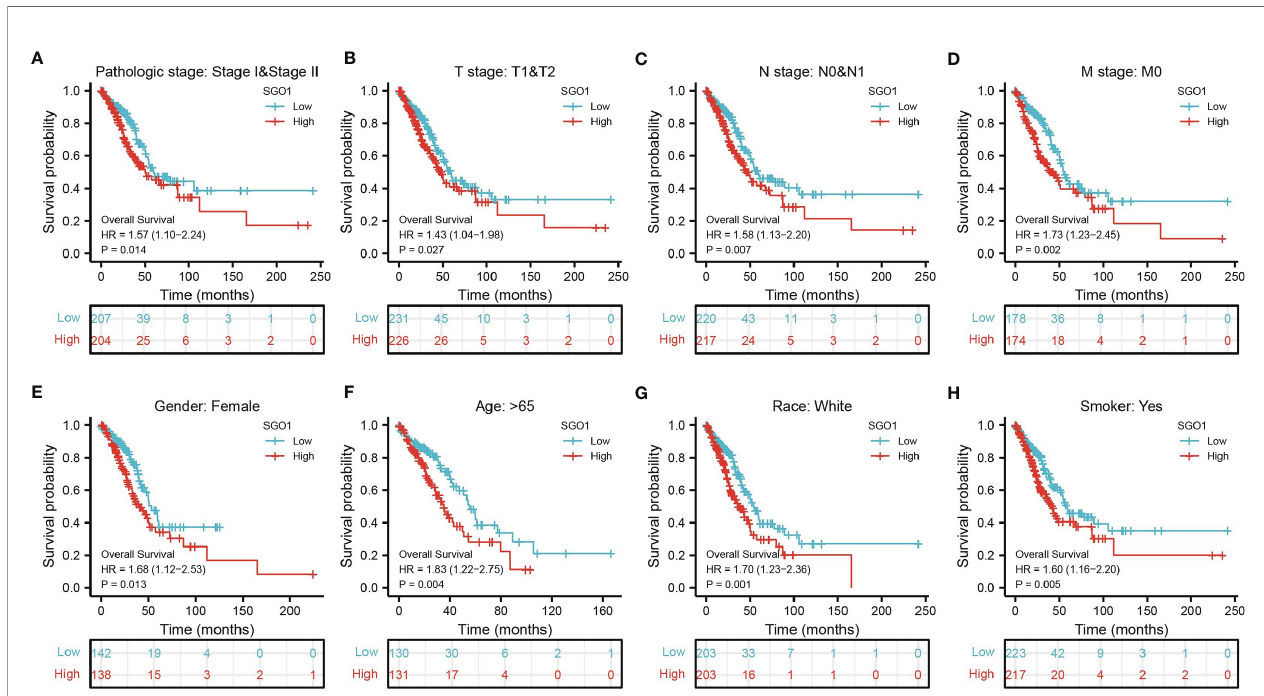
FIGURE 5 | The overall survival of SGO1 based on diverse subgroups. (A – H) The overall survival of SGO1 based on diverse subgroups, including stage I and II, T1 and T2, N0 and N1, M0, gender, age >65, White, and